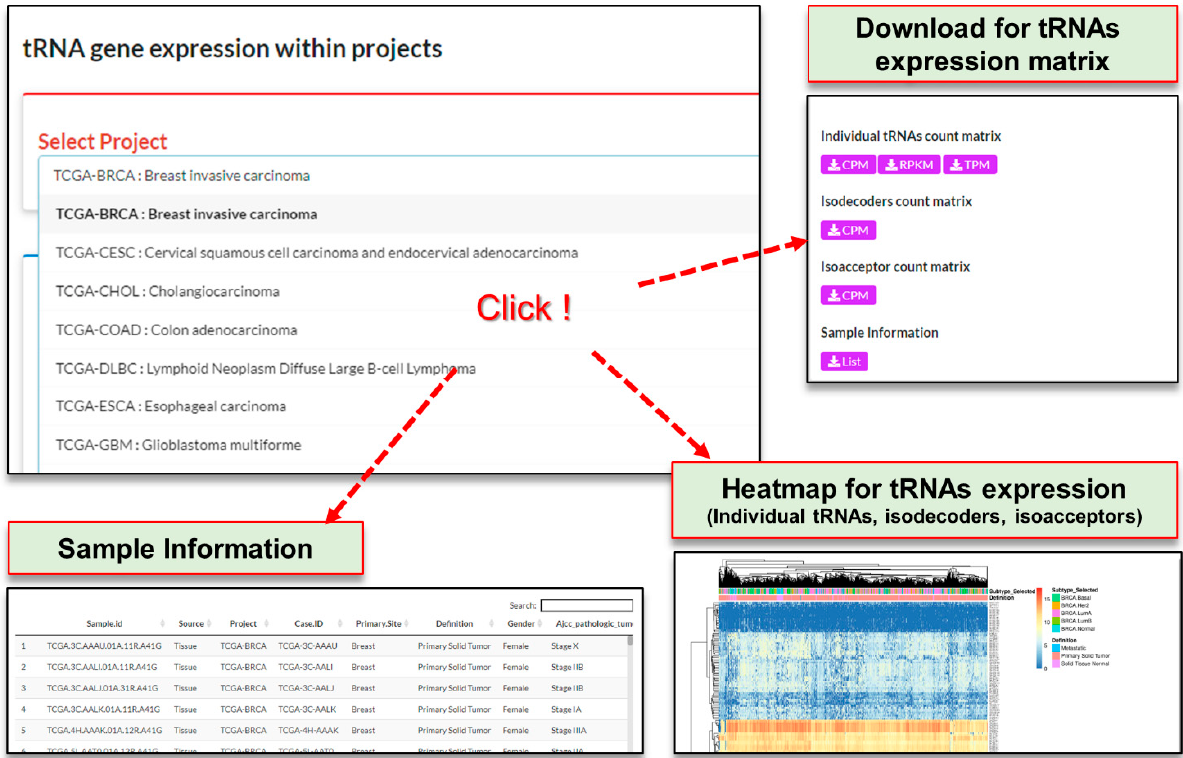
Figure 3. The ‘Explore Projects’ page.